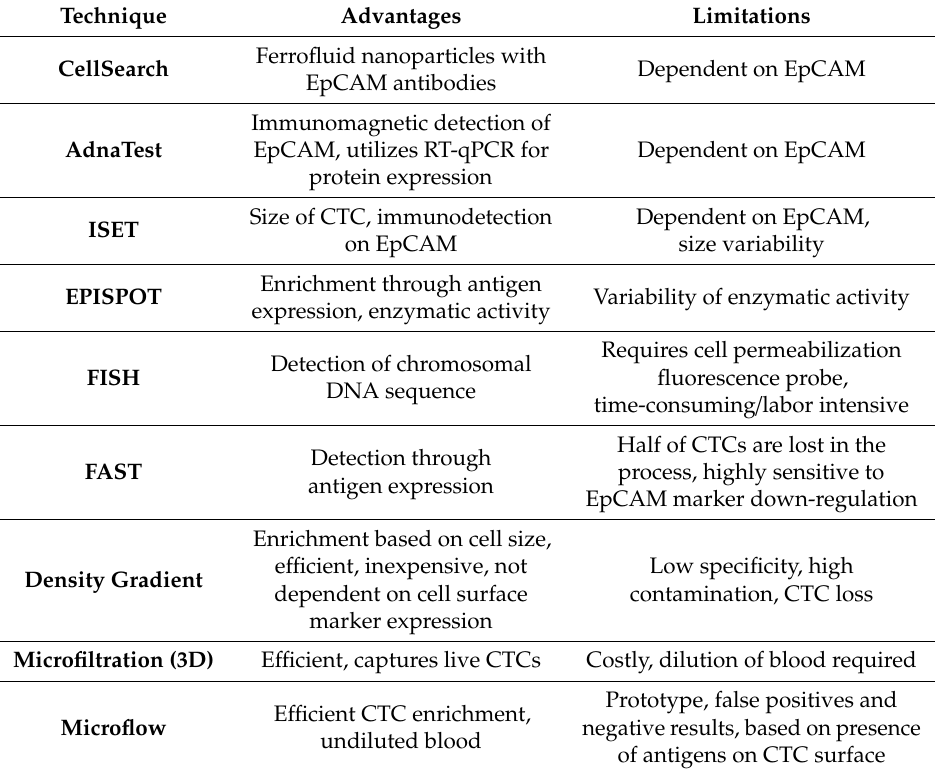
Table 1. Detection, Enrichment, and Separation Techniques for CTCs